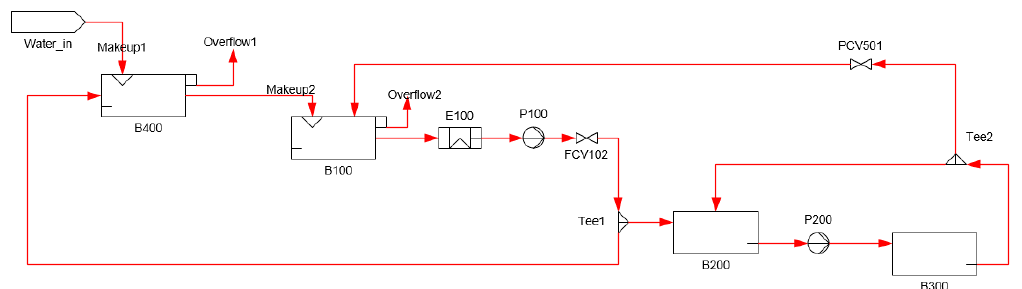
Figure 15. Final flowsheet of the steady state model resulting from expert manual finalizations of the model in Figure 14.